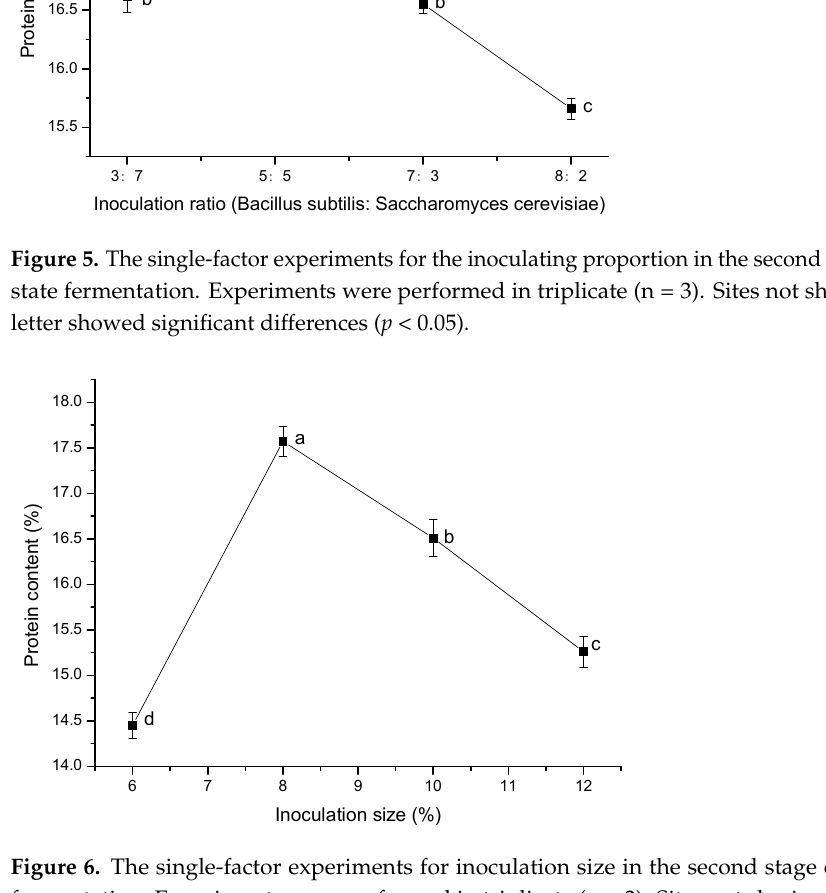
Figure 7. The single-factor experiments for the fermentation temperature in the second stage of the solid-state fermentation. Experiments were performed in triplicate (n = 3). Sites not sharing a com- mon le(cid:308)er showed significant differences ( p < 0.05).